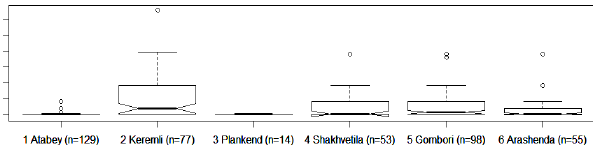
Fig. 11 . Box-and-whisker plots of “Bush and tree cover” on 100 m² in